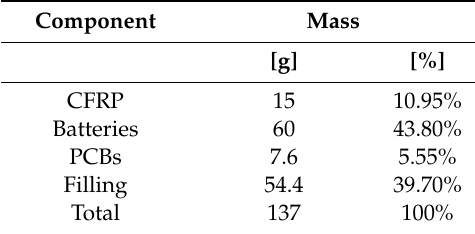
Table 4. Mass breakdown for the proposed design.